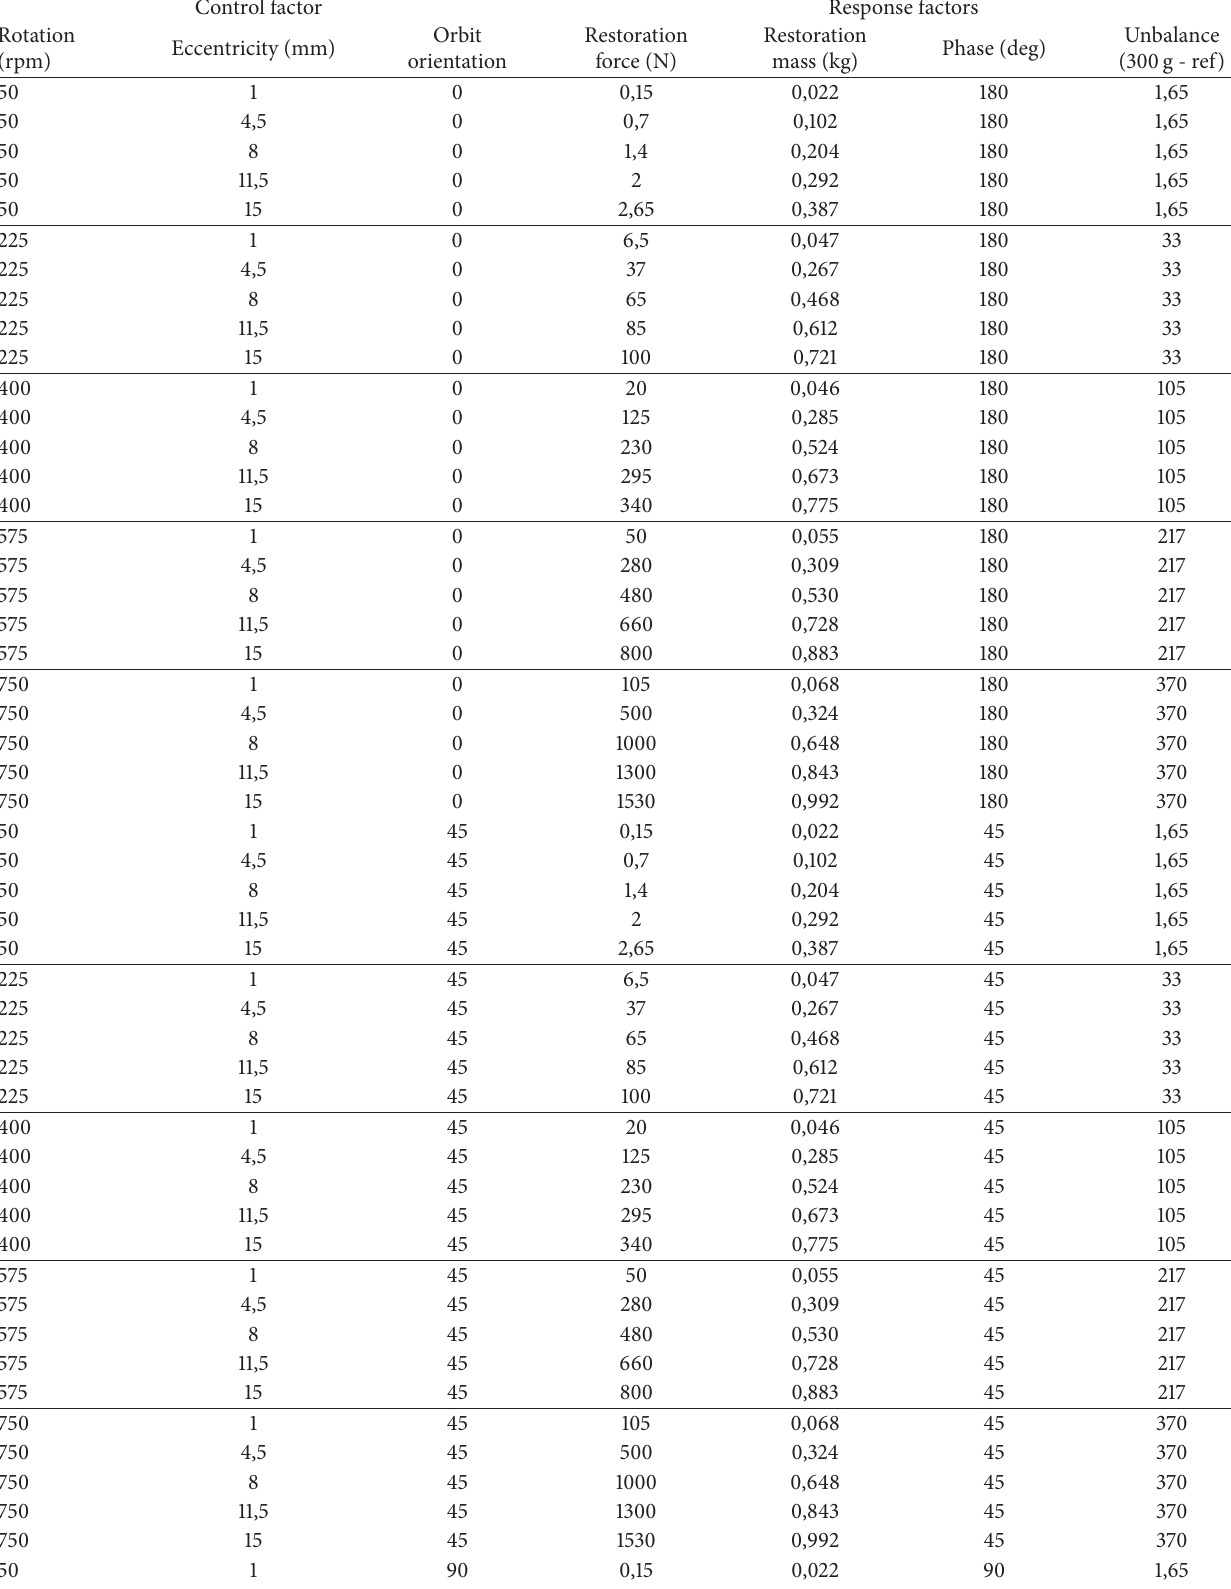
Table 3: Results of steady state